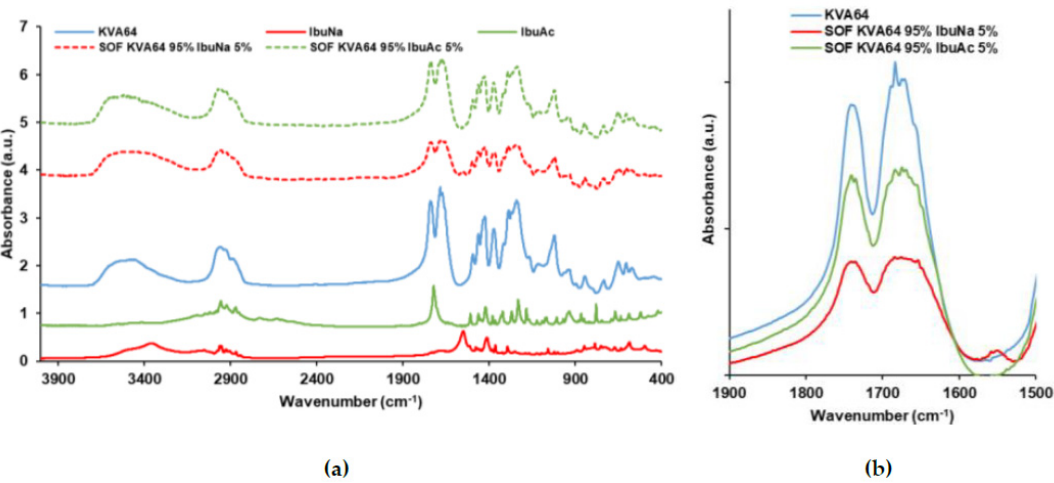
Figure 3. FTIR spectrums of KVA64, IbuNa, IbuAc and printed SOFs: ( a ) from 400 to 4000 cm − 1 , ( b ) from 1500 to 1900 cm − 1 .